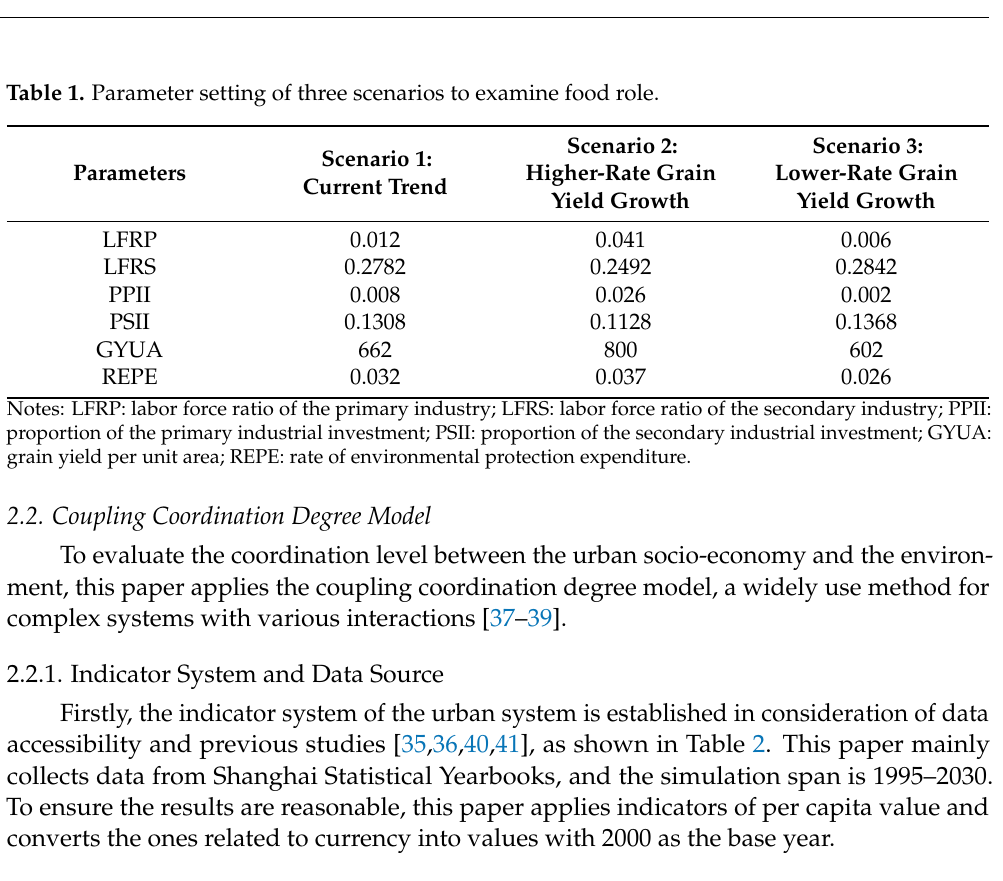
Table 2. Indicator system of the urban